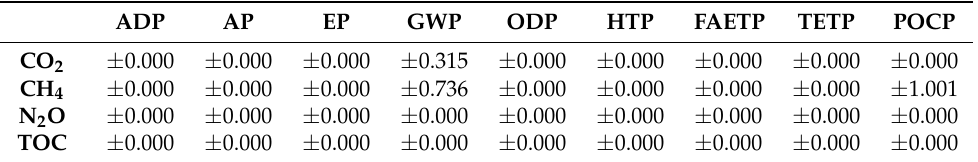
Table 5. The sensitivity analysis of the considered variables in relation to the environmental impact categories.